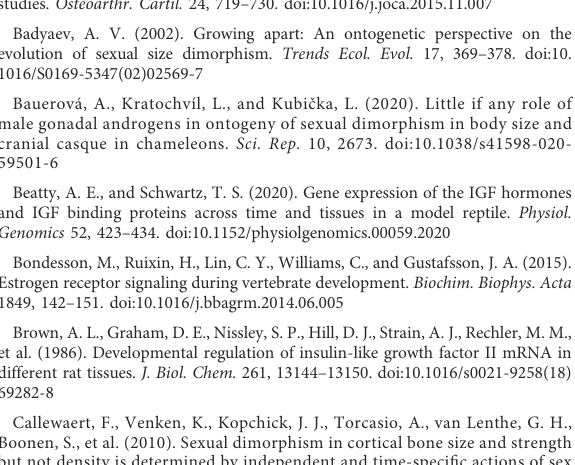
SUPPLEMENTAL FIGURE S1 Variation in estradiol plasma levels among groups. Note that estradiol levels generally increased and started to fl uctuate in females after they started reproduction (they were mated around the age of four months). Age groups with measured gene expression are marked.